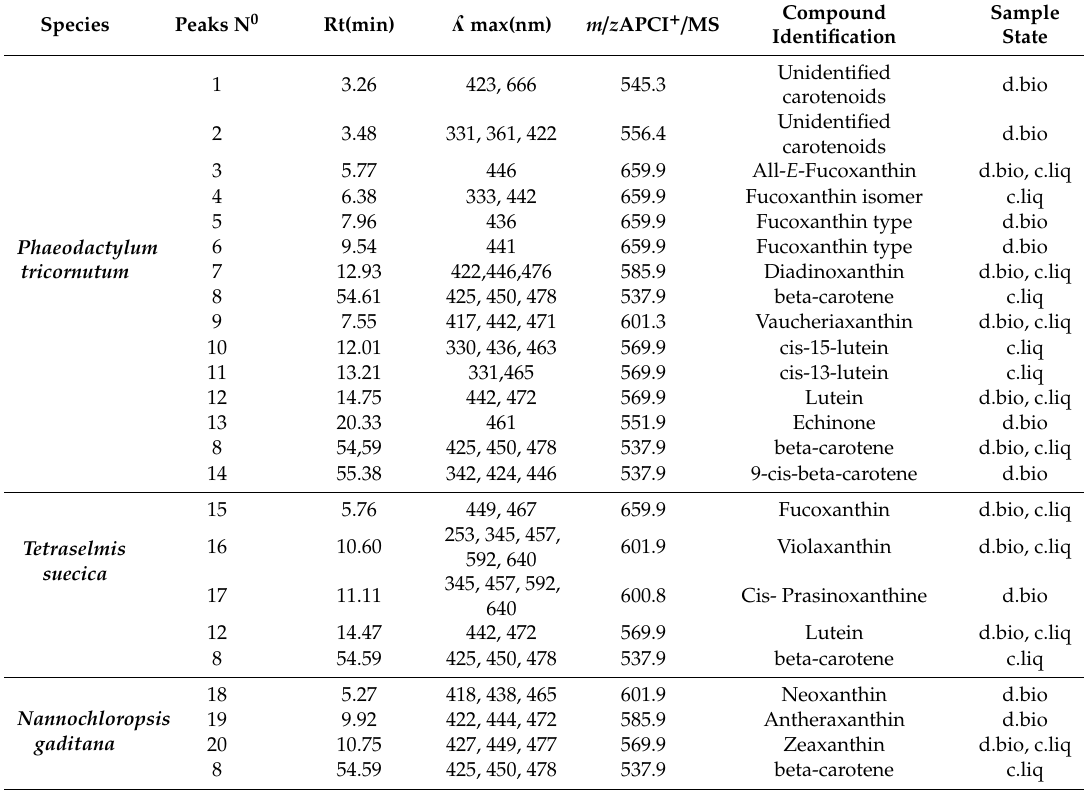
Table 5. Retention time and mass spectrometry characteristics for carotenoids tentatively identified in the four microalgae species investigated.